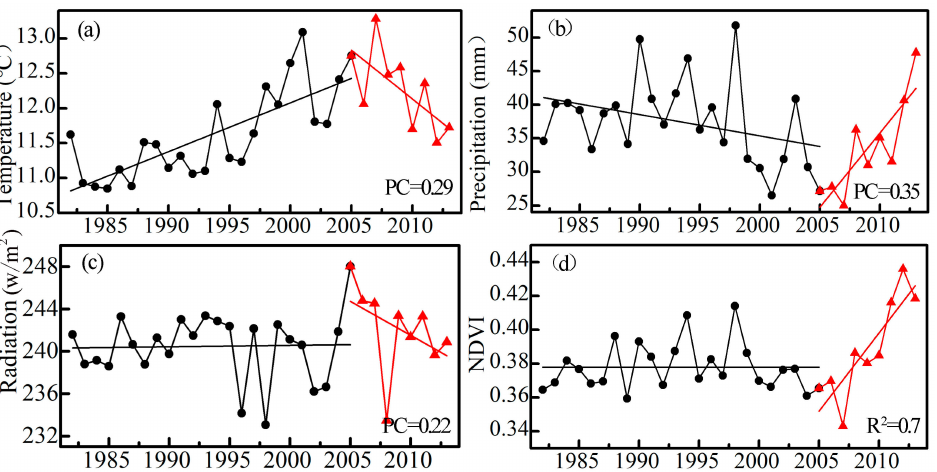
Figure 4. Climatic factors and NDVI variations in Mongolia from 1982–2013. ( a ) Temperature (T); ( b ) precipitation (P); ( c ) radiation (R); and ( d ) NDVI; the black line and the red line represent the changing trends before and after the temperature change. PC represents the partial correlation coefficient of each climatic factor with NDVI, excluding the other two meteorological variables, and R 2 represents the coefficient of determination between the NDVI and the meteorological factors. The relationship between NDVI and the climate factors is NDVI = 0.01T + 0.002P + 0.0004R +